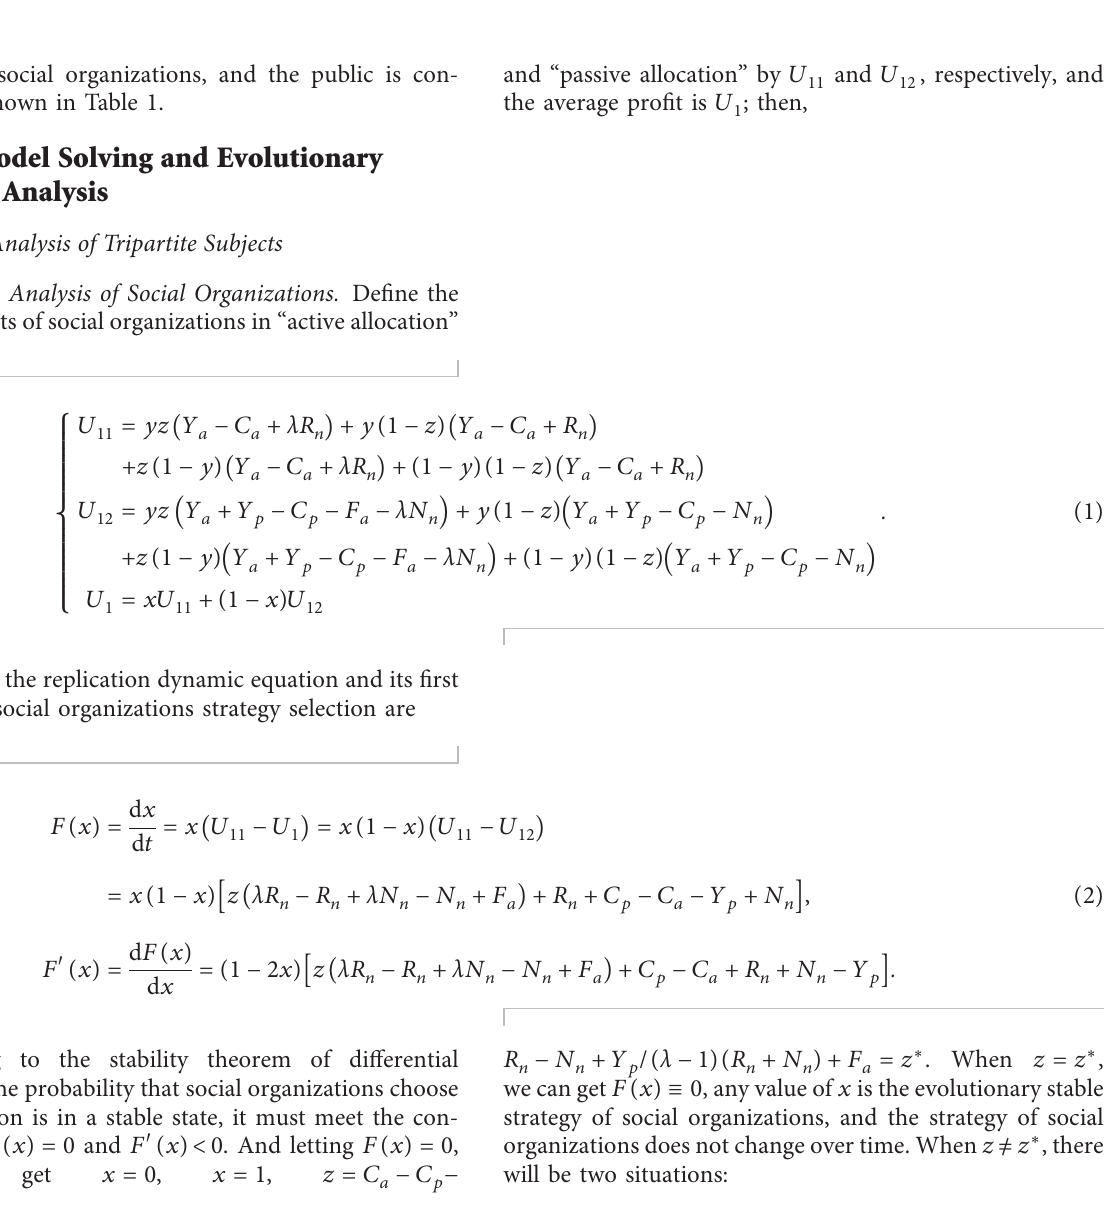
Figure 1: Mechanism of blockchain to emergency supply